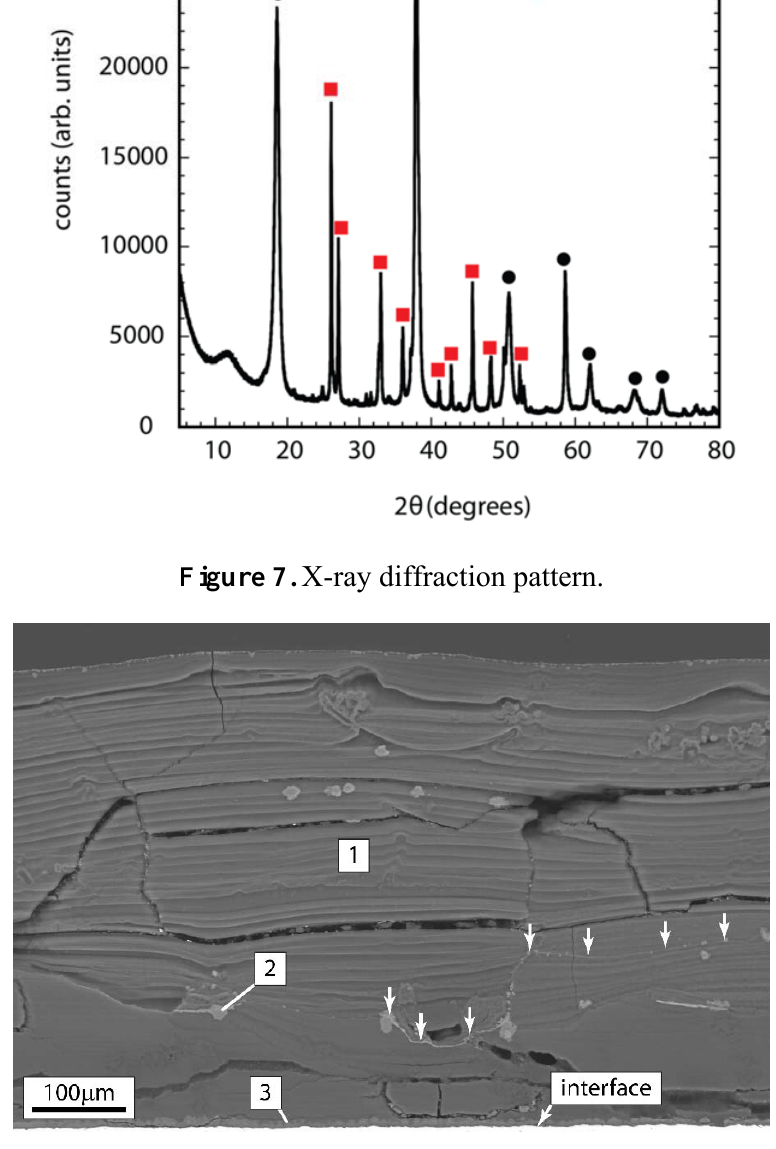
Figure 8. SEM image of the coating on carbon